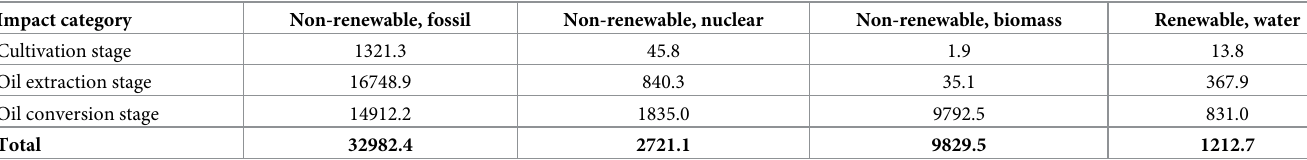
Table 3. Cumulative energy demand of JC biodiesel production chain in